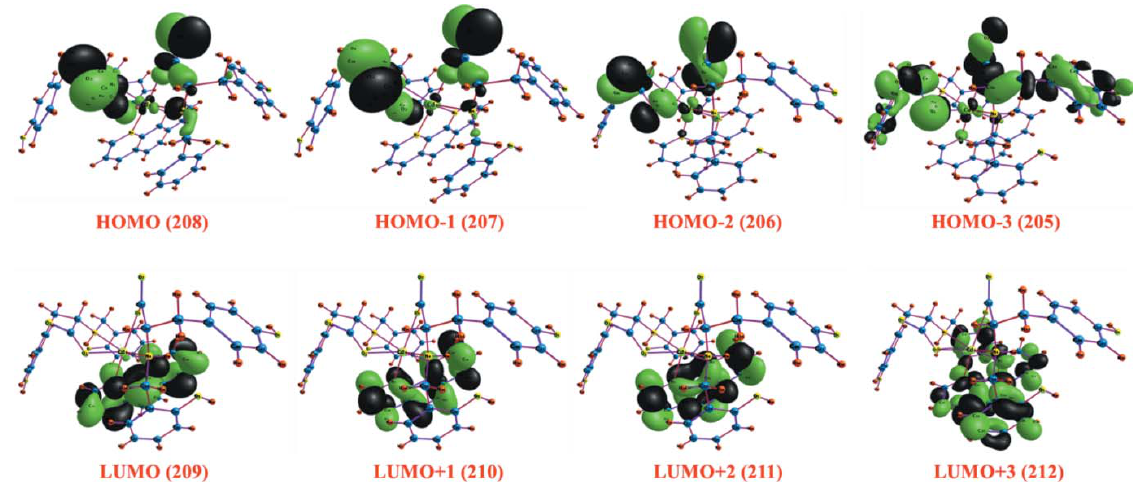
Figure 4 HOMO and LUMO frontier molecular orbitals with respective molecular orbital number.